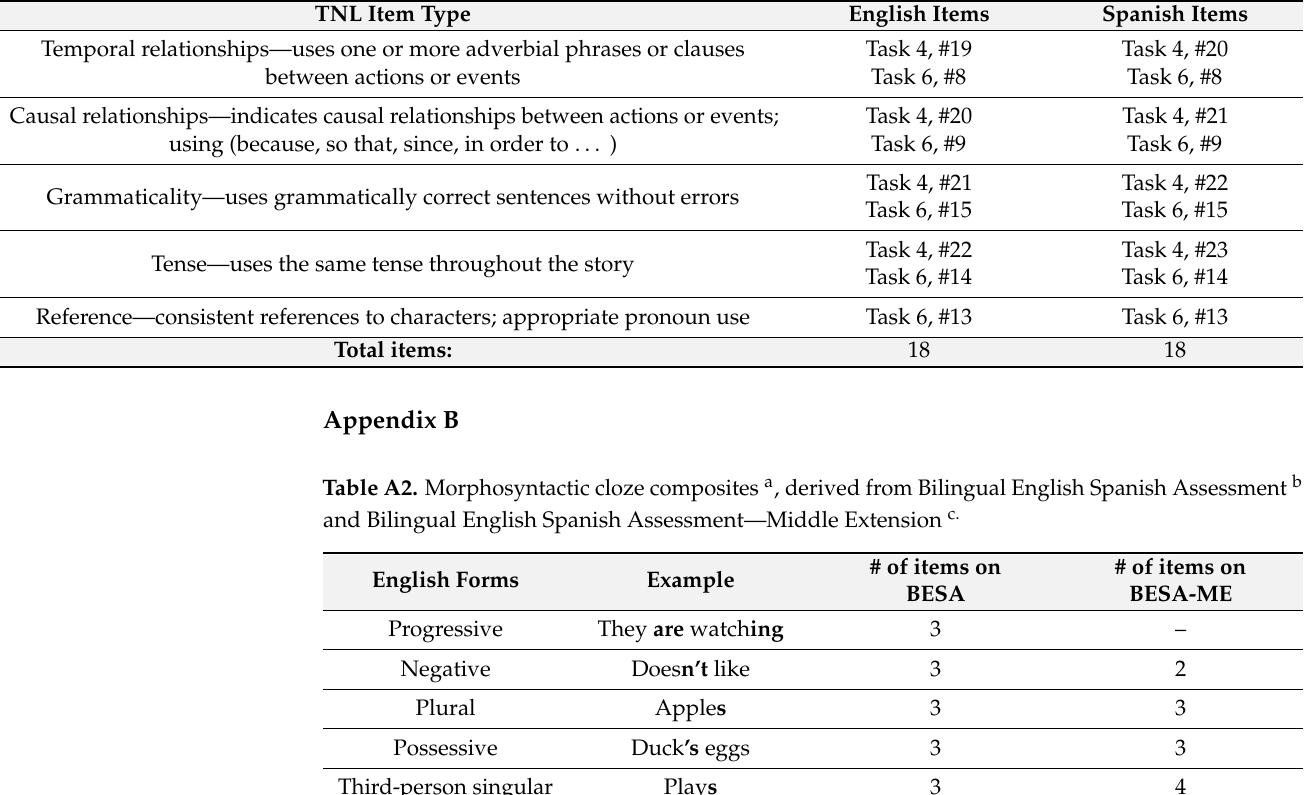
Table A1. Morphosyntactic composites in English and Spanish derived from performance on Test of Narrative Language in English and Spanish. TNL Item Type English Items Spanish Items